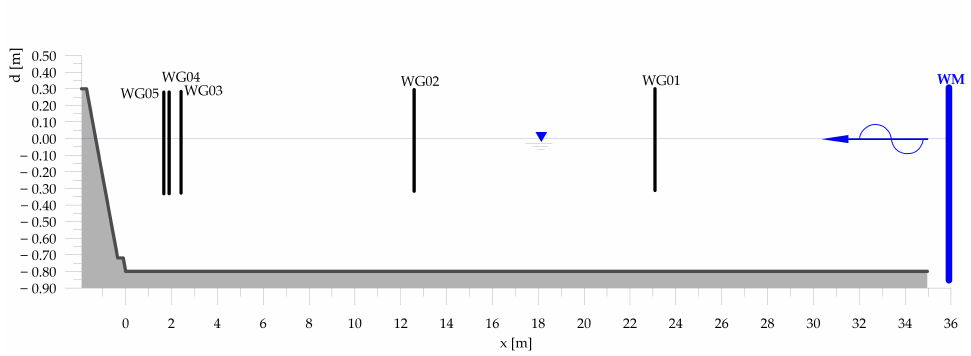
Figure 4. Wave gauge positions along the channel.